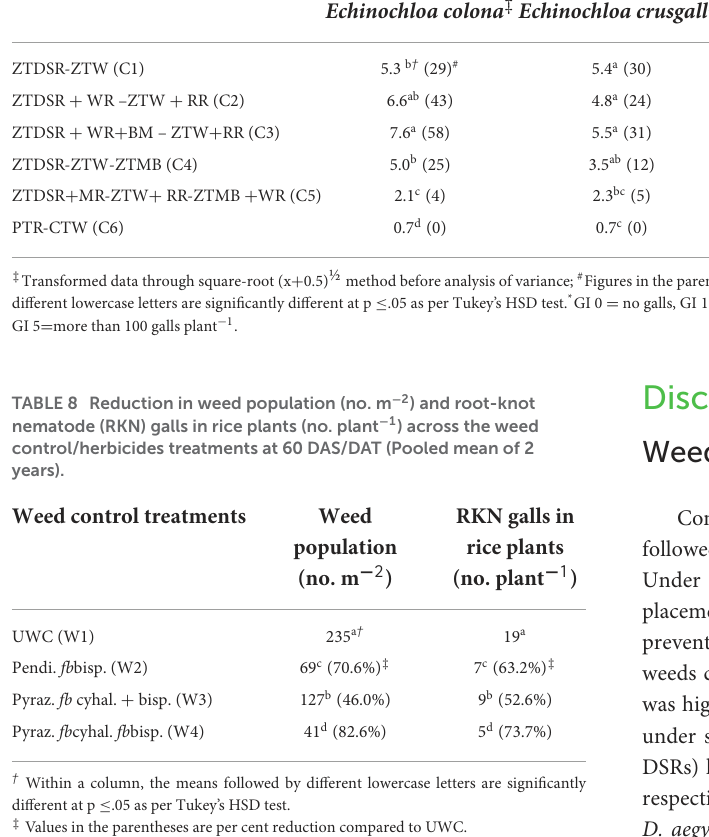
TABLE 7 Root-knot nematode (RKN) galls (no. plant − 1 ) and gall index (GI) in weeds Echinochloa colona, Echinochloa crusgalli, and rice crop under unweeded control at 60 DAS/DAT across the conservation agriculture practices (mean of 2 years). Treatments